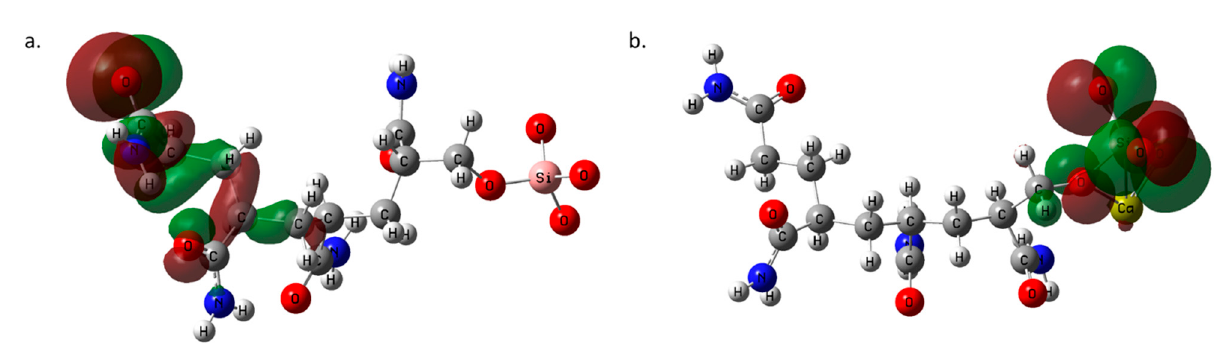
Figure 5. The Highest Occupied Molecular Orbital (HOMO) maps for ( a ) PAM-Silica and ( b ) Ca- PAM_Silica.